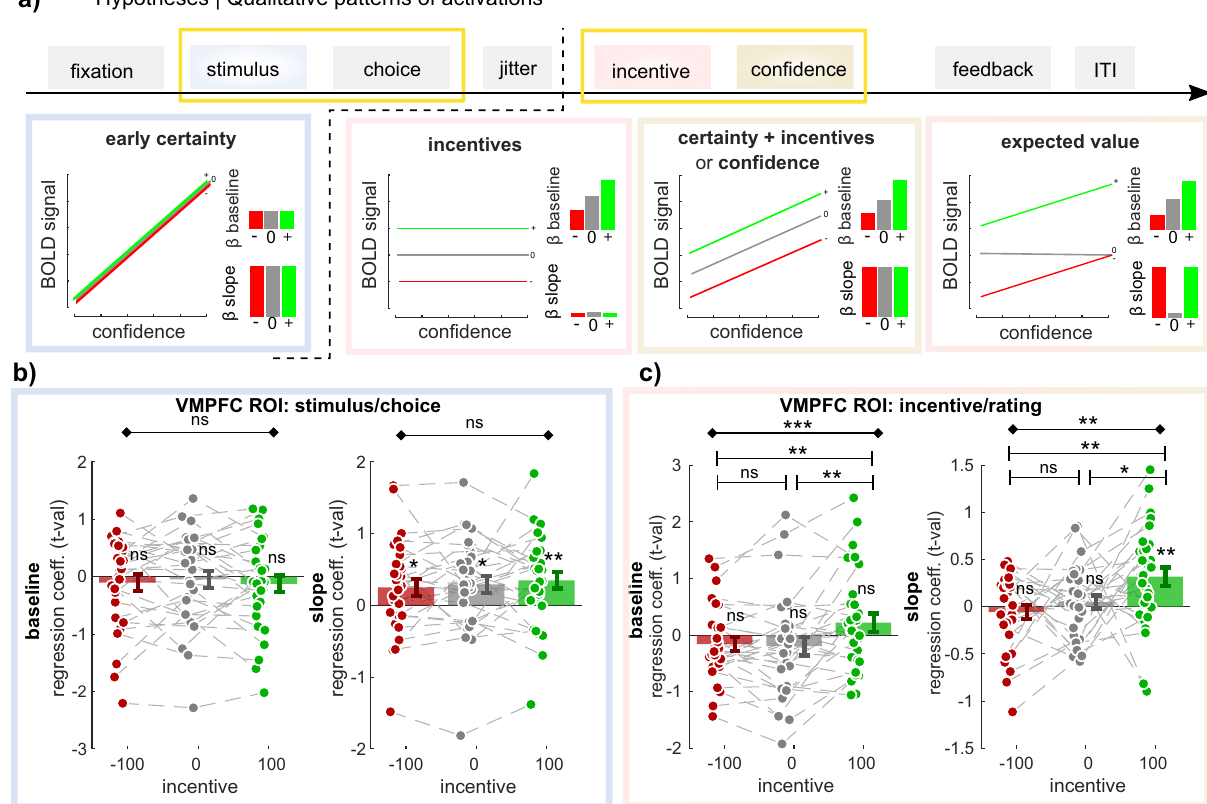
Fig. 5 Activation in ventromedial prefrontal cortex across incentives and time points. a Qualitative ventromedial prefrontal cortex (VMPFC) activation patterns predicted under different models. The different boxes present how blood-oxygen-level-dependent (BOLD) signal should vary with increasing con fi dence in the three incentive conditions (green: + 100; gray: 0; red: − 100), under different hypotheses (i.e., encoding different variables), at different time points. Bar graphs in insets summarize these relationships as expected intercepts (or baseline — top) and slope (bottom). b – c VMPFC region of interest (ROI) analysis ( N = 30). T values corresponding to baseline and regression slope were extracted in the three incentive conditions, and at the two time points of interest ( b : stimulus/choice; c : incentive/rating). Dots represent individual activations; bar and error bars indicate sample mean ± standard error of the mean. Gray lines highlight within-subject variation across the different incentive conditions. Diamond-ended horizontal bars indicate the results of repeated-measure ANOVAs. Dash-ended horizontal bars indicate the result of post hoc paired t tests. ns: P > 0.05; * P < 0.05; ** P < 0.01; *** P < 0.001.